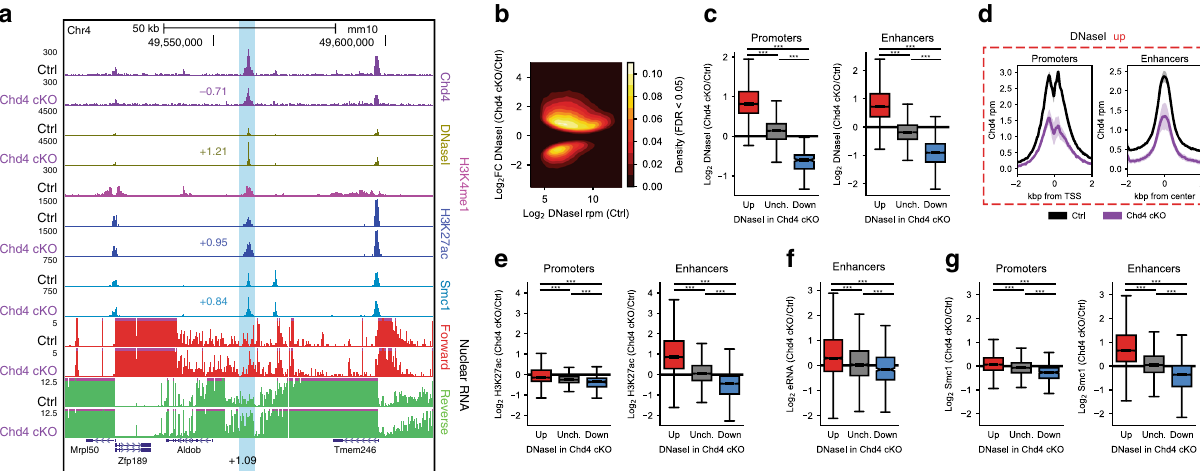
Fig. 1 Chd4 preferentially modulates enhancer activation and cohesin binding. a Genome-browser snapshot of a region containing the Aldob gene locus on chromosome 4 displaying the ChIP-seq pro fi les of Chd4, H3K4me1, H3K27ac and Smc1 as well as DNaseI-seq and nuclear RNA-seq from the control and Chd4 cKO cerebellum. Light blue denotes an enhancer upstream of the Aldob gene. Numbers indicate the Log2 change in signal in the Chd4 cKO cerebellum, including that of eRNA. b MA density plot of DHS sites called as signi fi cant (FDR < 0.05) by DESeq2. c Boxplot of DnaseI change between the Chd4 cKO and control cerebellum at (left) promoters and (right) enhancers with increased ( n = 19,389 promoters; n = 67,245 enhancers), unchanged ( n = 15,141 promoters; n = 44,661 enhancers), and decreased ( n = 828 promoters, n = 27,750 enhancers) accessibility. d Aggregate plot of Chd4 density in the control and Chd4 cKO cerebellum at (left) promoters and (right) enhancers with increased accessibility. Mean ± SEM. e Boxplot of H3K27ac change between the Chd4 cKO and control cerebellum at (left) promoters and (right) enhancers with increased ( n = 19,389 promoters; n = 67,245 enhancers), unchanged ( n = 15,141 promoters; n = 44,661 enhancers), and decreased ( n = 828 promoters, n = 27,750 enhancers) accessibility. f Boxplot of eRNA change between the Chd4 cKO and control cerebellum at enhancers with increased ( n = 2969), unchanged ( n = 1455), and decreased ( n = 526) accessibility. g Boxplot of Smc1 change between the Chd4 cKO and control cerebellum at (left) promoters and (right) enhancers with increased ( n = 19,389 promoters; n = 67,245 enhancers), unchanged ( n = 15,141 promoters; n = 44,661 enhancers), and decreased ( n = 828 promoters, n = 27,750 enhancers) accessibility. P -values for all comparisons in this fi gure were calculated by the two-sided Kruskal – Wallis H-test for independent samples with Dunn ’ s post hoc T-test and corrected for multiple comparisons by the Bonferroni – Hochberg procedure. p < 0.001